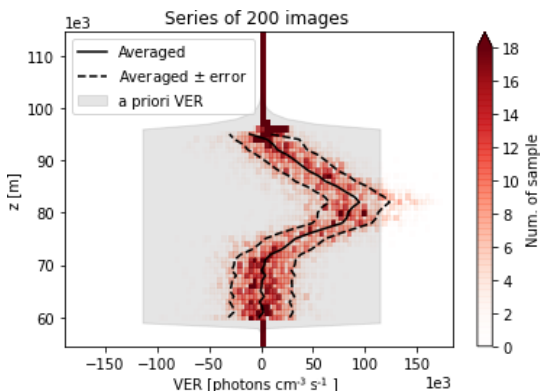
Figure 4. Histogram of the volume emission rate (VER) profiles retrieved from the first 200 images taken in orbit 10122 (see Fig. 7 for the whole orbit). Superimposed is the averaged VER (solid line) and ± retrieval noise uncertainty (dashed lines), where the averag- ing kernel matrix is maximum at rows larger than 0.8 (see Fig. 5). The a priori mean (zero) and uncertainty are illustrated by the grey shading.